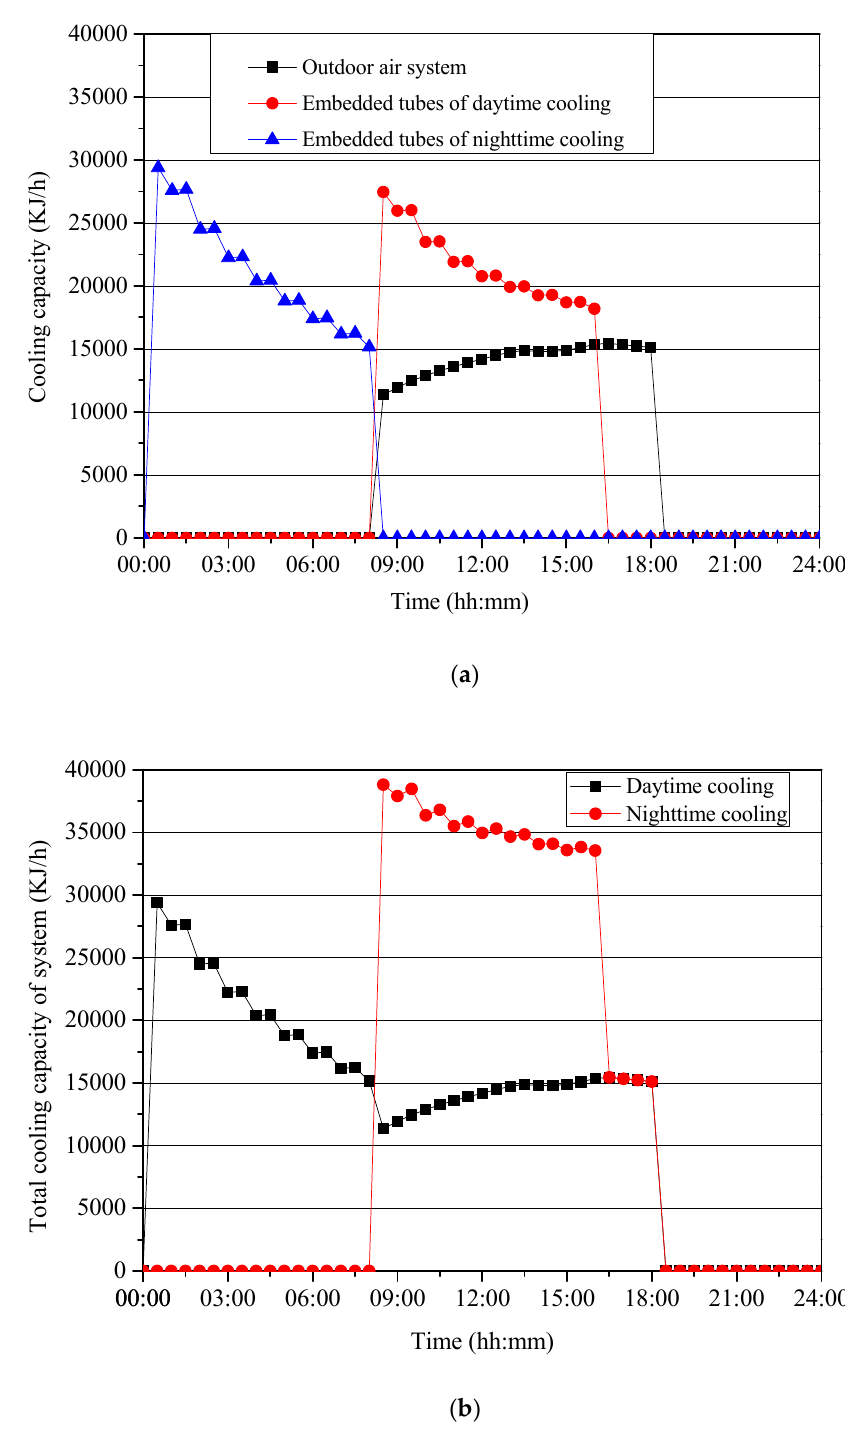
Figure 9. System cooling capacity variation trends during a typical day. ( a ) Embedded tubes and outdoor air system; ( b ) composite system. outdoor air system; ( b ) composite